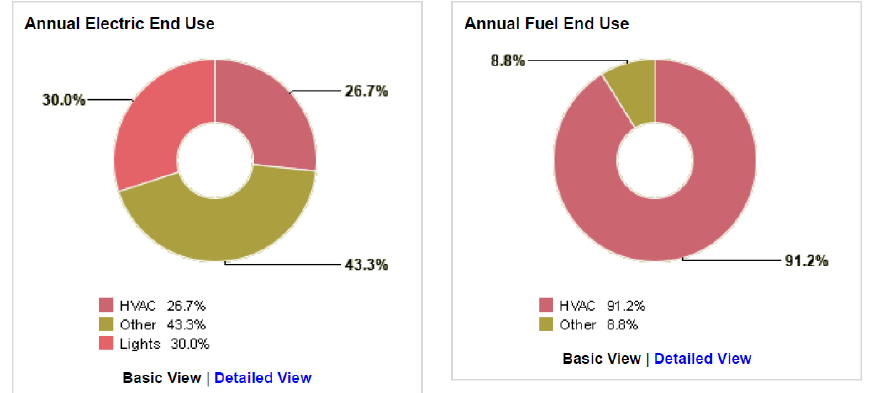
Figure 23 . Annual costs of Single skin facade (Green Building Studio).